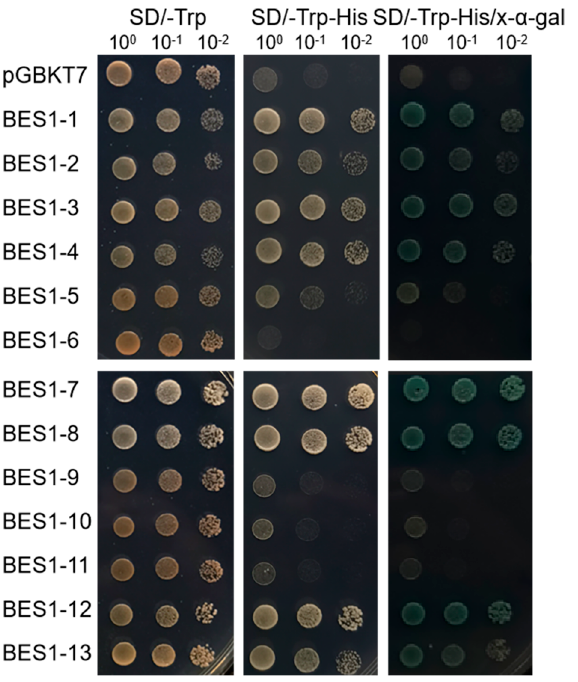
Figure 8. Transactivation assays of 13 BES1 proteins in yeast cells. The transformed yeast grown on SD/-Trp media or SD/-Trp-His media. LacZ activity was assessed by β− galactosidase filter lift assay. Empty vector pGBKT7 was used as a negative control. The length of the scale bar is 4 mm.